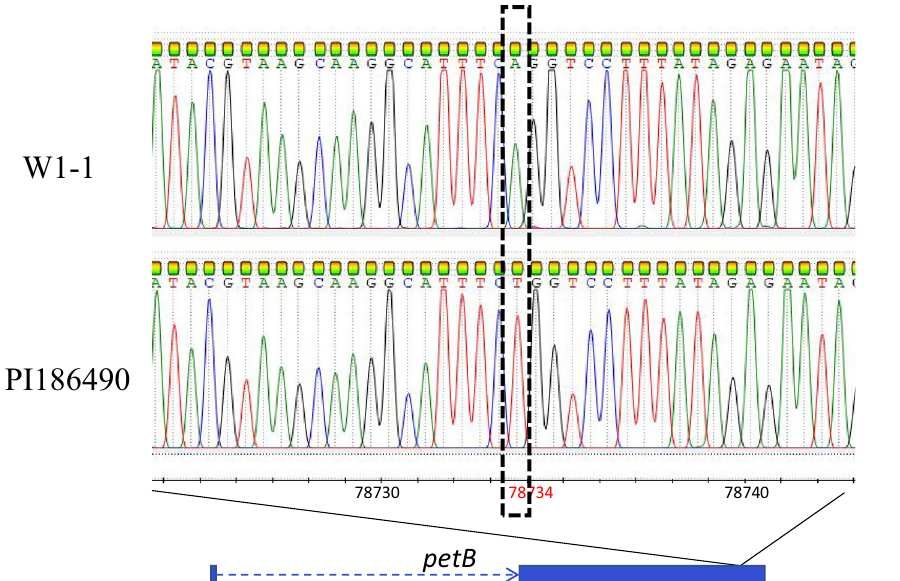
Figure 6. Targeted pyrosequencing assays of petB in W1-1 ( C. lanatus subsp . vulgaris ) and PI186490 ( C. mucosospermus